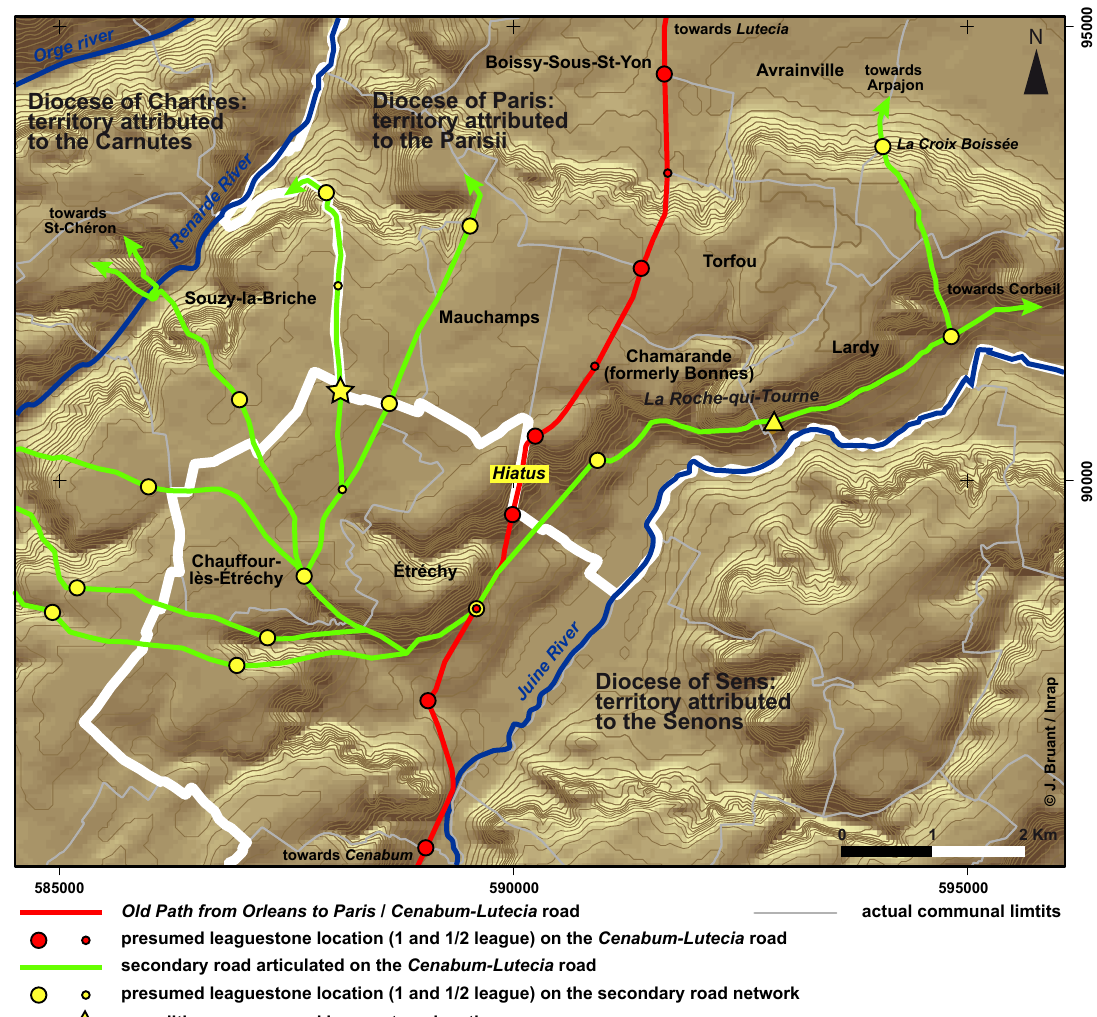
Fig. 10 - Implications of road survey in the delimitation of the dioceses of Paris, Chartres and Sens and the civitates of the Parisii, the Carnutes and the Senons. © J. Bruant, R. Touquet/Inrap. This work has revealed an important number of routes paced by the measurement of the gallo-roman league (2222 m), originating from the leaguestones of the Cenabum-Lutecia road. At Étréchy, the observed overlap between the territorial confines of Carnutes, Senons, and Parisii, and the supposed location of a